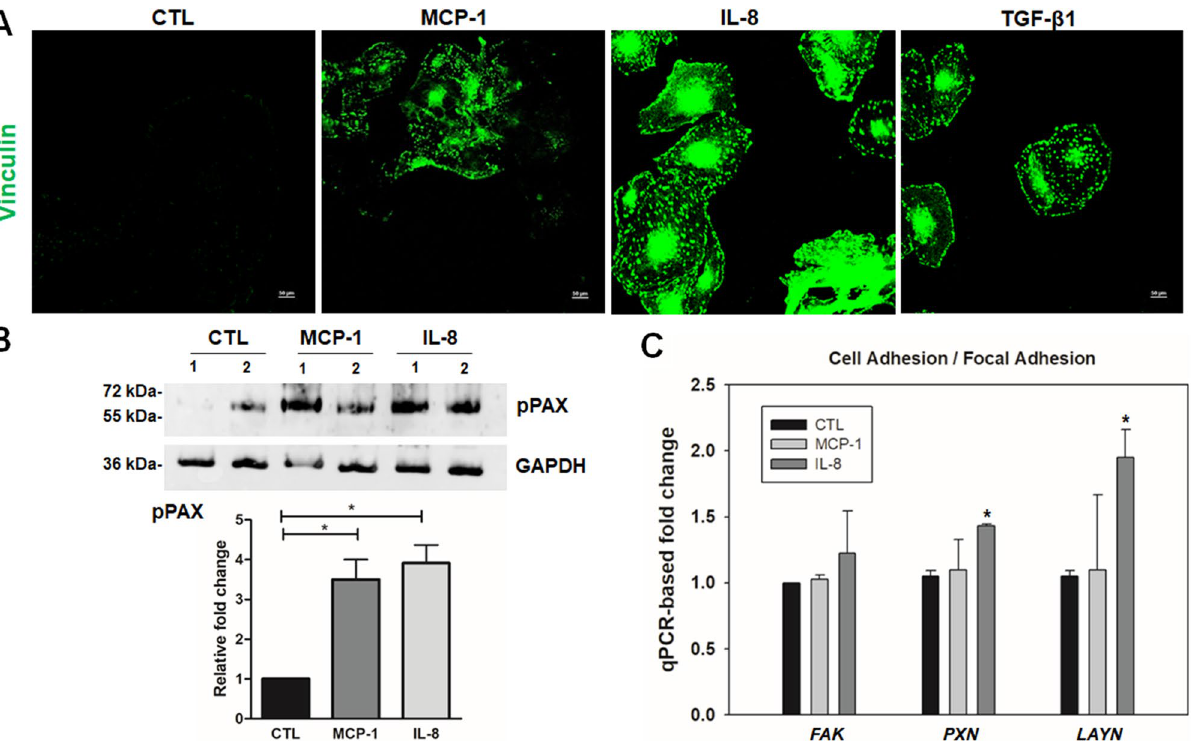
Figure 4. MCP-1 and IL-8 treatment induces changes in focal adhesions in human TM cells. Primary cultured TM cells we generated were cultured on 2% gelatin-coated glass cover slips and serum-starved for 24 h and treated with MCP-1 (100 ng/ml) or IL-8 (100 ng/ml) for 2 h or TGF-β1 (10 ng/ml) for 24 h before staining for focal adhesion (vinculin staining). ( A ) Representative confocal images of stained cells show an increase in focal adhesions (green) which is prominent with IL-8 treatment. TM cells treated with MCP-1 and IL-8 showed a significant increase in the level of phosphorylated Paxillin ( B ) relative to control (CTL) based on immunoblotting and densitometric analyses. The immunoblot data were normalized to GAPDH. qPCR-based confirmation of MCP-1 and IL-8 induced gene expression related to cell focal adhesion in human TM cells ( FAK, Paxillin, LAYN ) ( C ). qPCR analyses revealed a significant increase in expression of Paxillin and LAYN (in fold change) upon IL-8 treatment as compared with the controls. Full-length blots/gels are presented in Supplementary Figure S3. Values are mean ± SEM and one-way ANOVA with Dunnett’s multiple comparison was done. * P < 0.05, N =